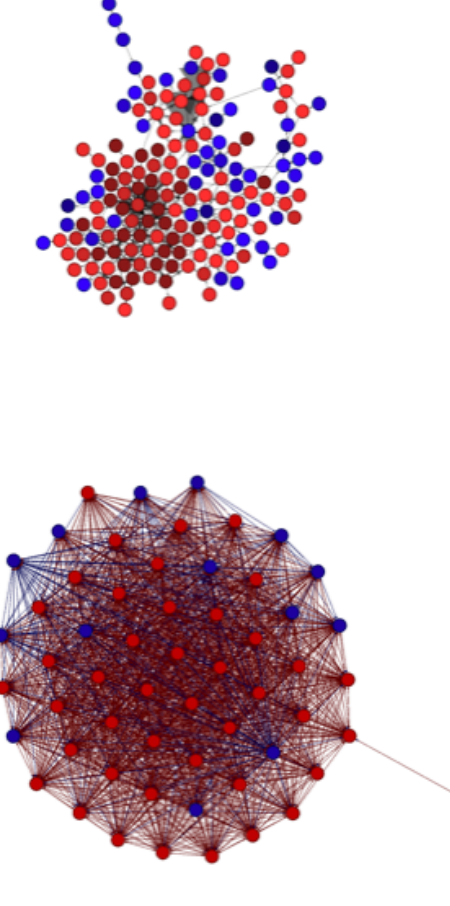
Inter-Community Posting as an